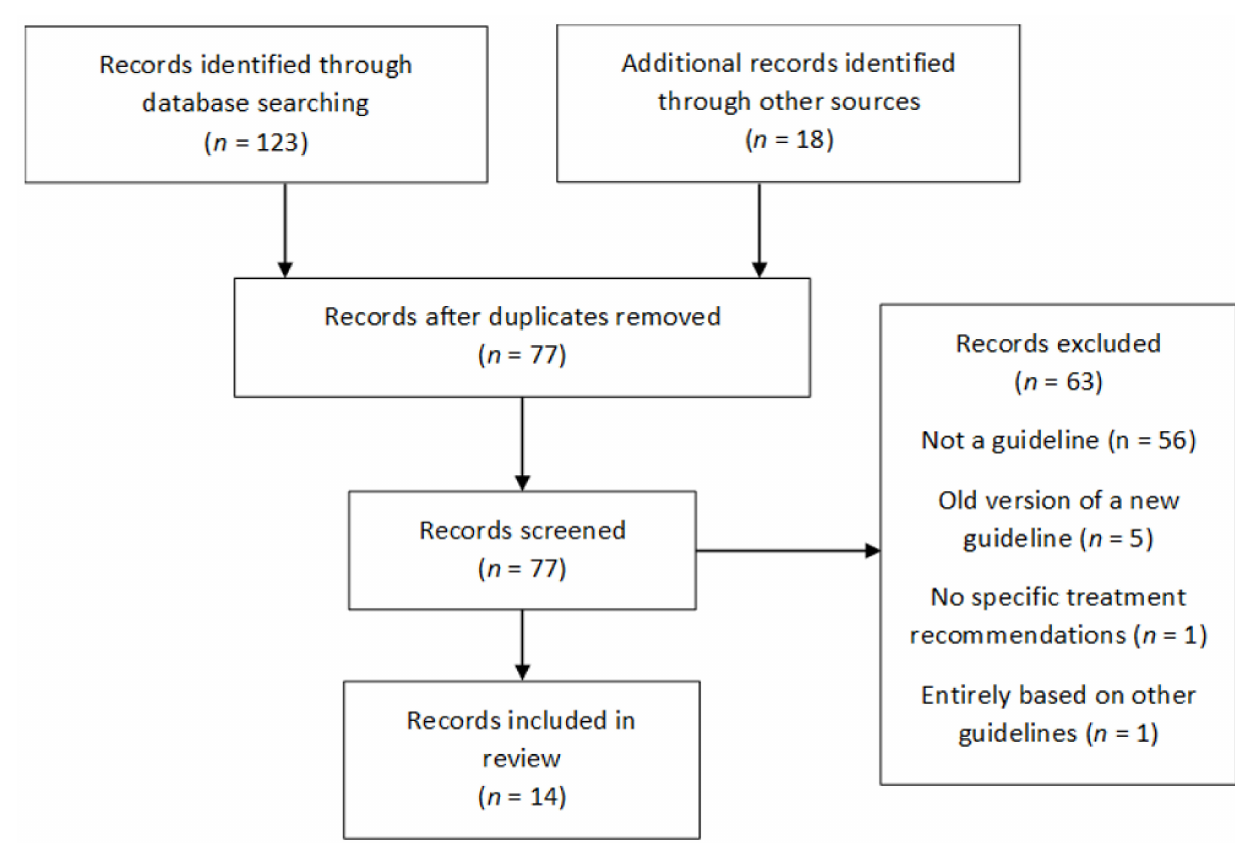
Figure 1. PRISMA Flow